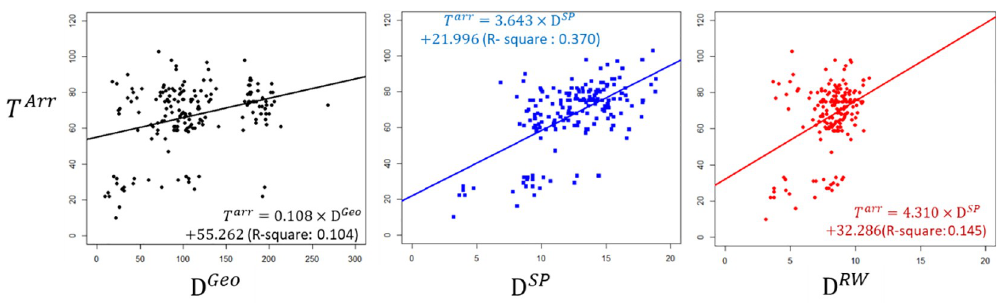
Fig 7. Scatter plot of the geographic distance. (a) the shortest-path and the random–walk effective distance (c) from Wuhan Airport to the other airports, and the arrival time of COVID-19.